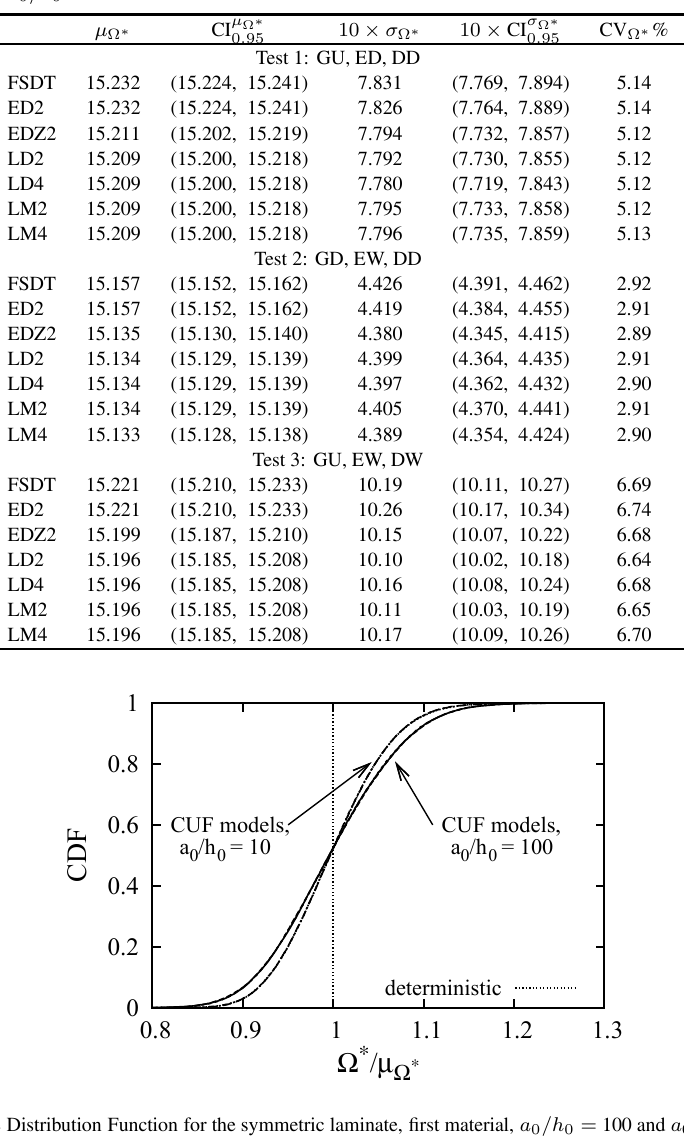
Ω ∗ statistic estimators in the case of the symmetric laminate, second material and a 0 /h 0 = 100.